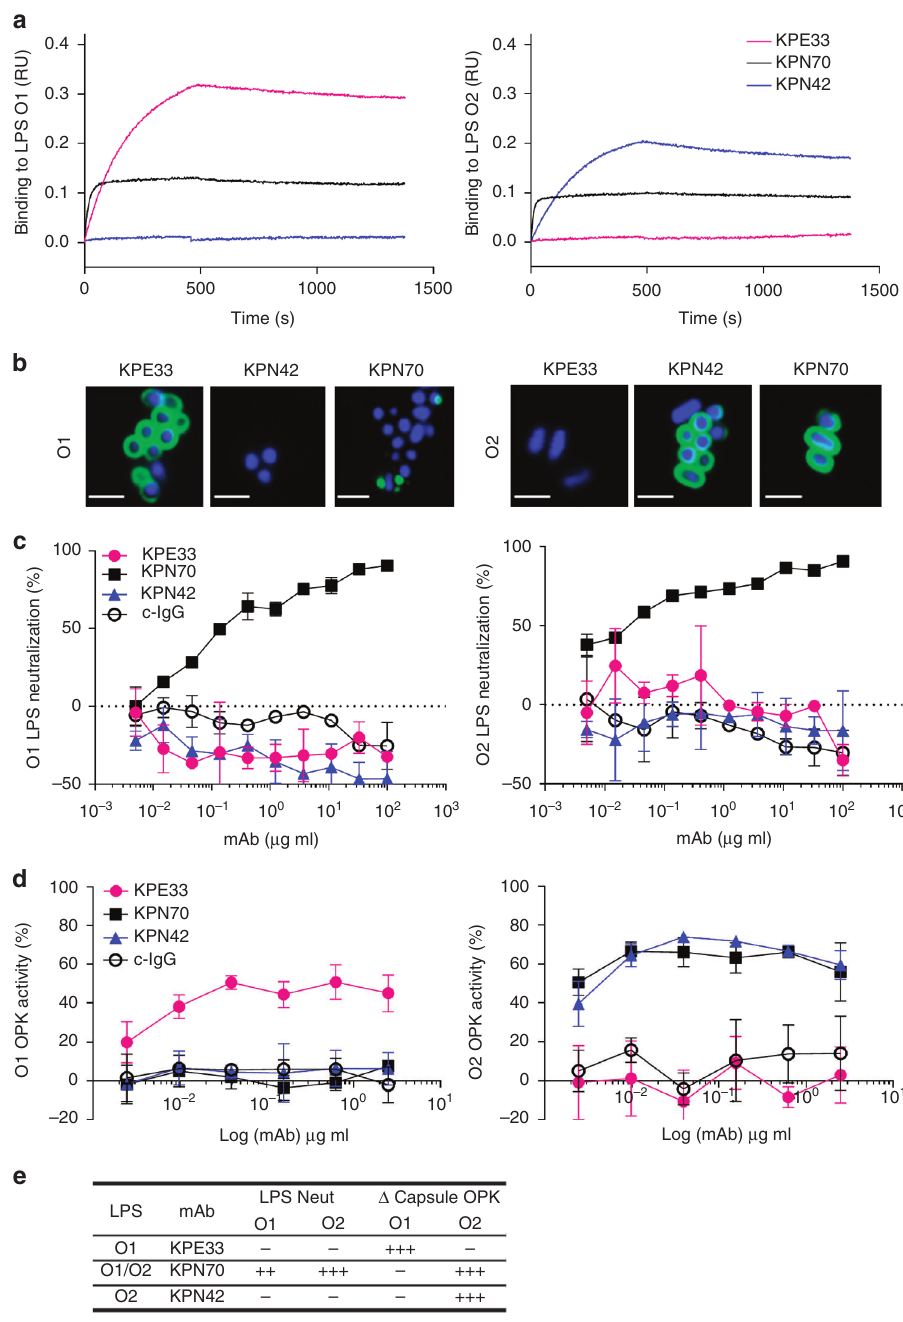
Fig. 4 In vitro characterization of anti-O antigen mAbs. a Association/dissociation curves of K. pneumoniae O1 or K. pneumoniae O2 LPS binding to mAbs KPE33, KPN70, and KPN42 were measured by ForteBio Octet using protein A capture probe pre-loaded with each mAb. b Confocal images of mAb binding to an O1 (Kp43816) or O2 (Kp9148) strain (scale bar, 2 μ m). c LPS neutralization was measured using RAW264.7 cells transfected with a NK-kB driven luciferase promoter stimulated with 2 ng ml − 1 of puri fi ed O1 or O2 LPS in the presence of KPE33, KPN70, KPN42 or the isotype-matched control mAb (c- IgG). Percent inhibition was calculated as the amount of luminescence (RLU) in treated wells divided by the RLU in wells stimulated with LPS alone multiplied by 100. d Opsonophagocytic killing assays were performed using various concentrations of mAbs in the presence of the phagocytic cell line HL- 60. The capsule-de fi cient luminescent mutants Kp43816 Δ cpsB and Kp8570 Δ cpsB were used as the O1 and O2 serotype targets, respectively. Percent killing was calculated based on the amount of luminescence after 2.5 h incubation in treated wells vs. wells with bacteria only. An isotype-matched mAb (c- IgG) is used as a negative control. e Summary of the in vitro functional activities against O1 and O2 K. pneumoniae for each mAb. All error bars indicate s.d. at each data